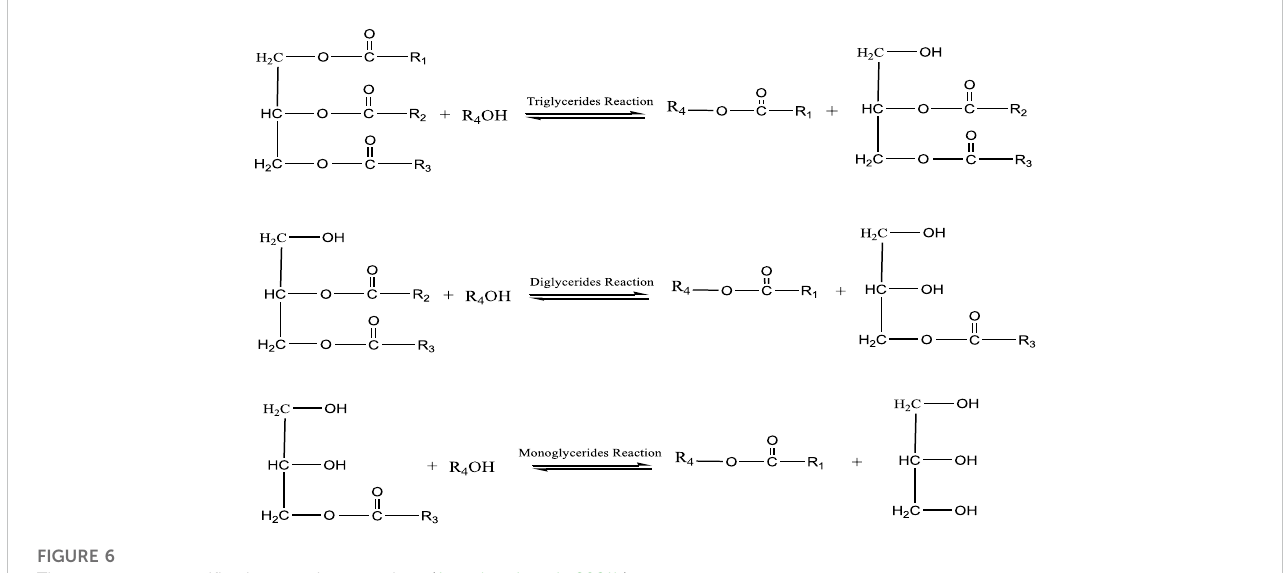
FIGURE 6 Three-step transesteri fi cation reaction equations (Awogbemi et al.,